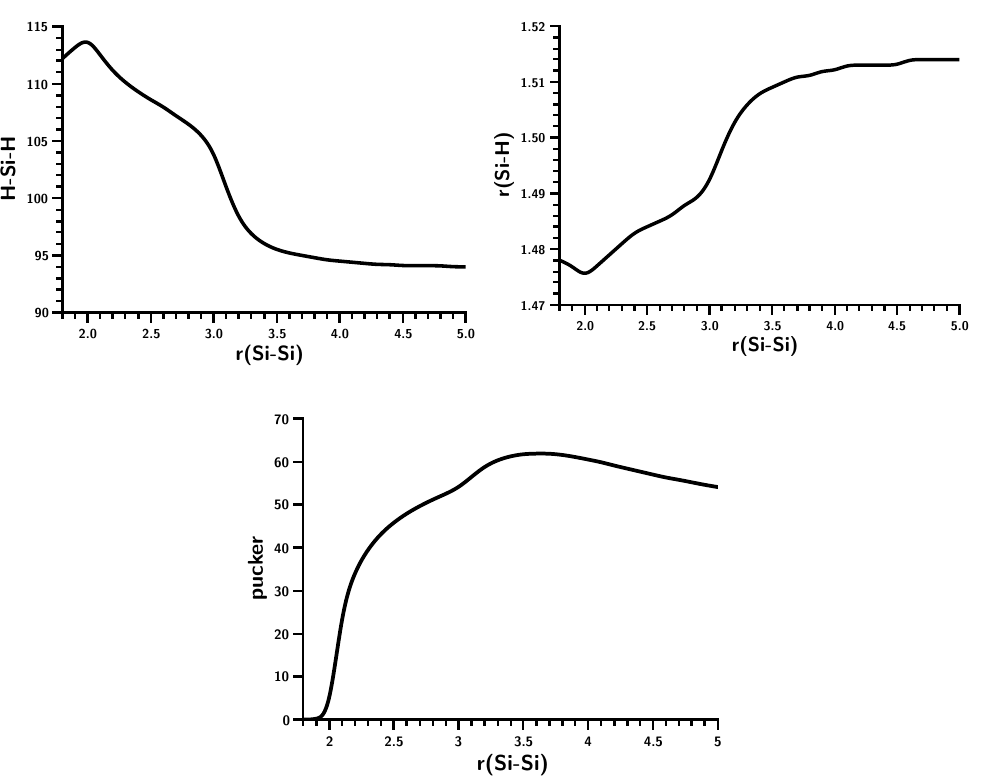
Figure 12. Non-planar silylene dimerization. HSiH bond angle, SiH bond length and pucker angle. Angle in degrees; bond length in